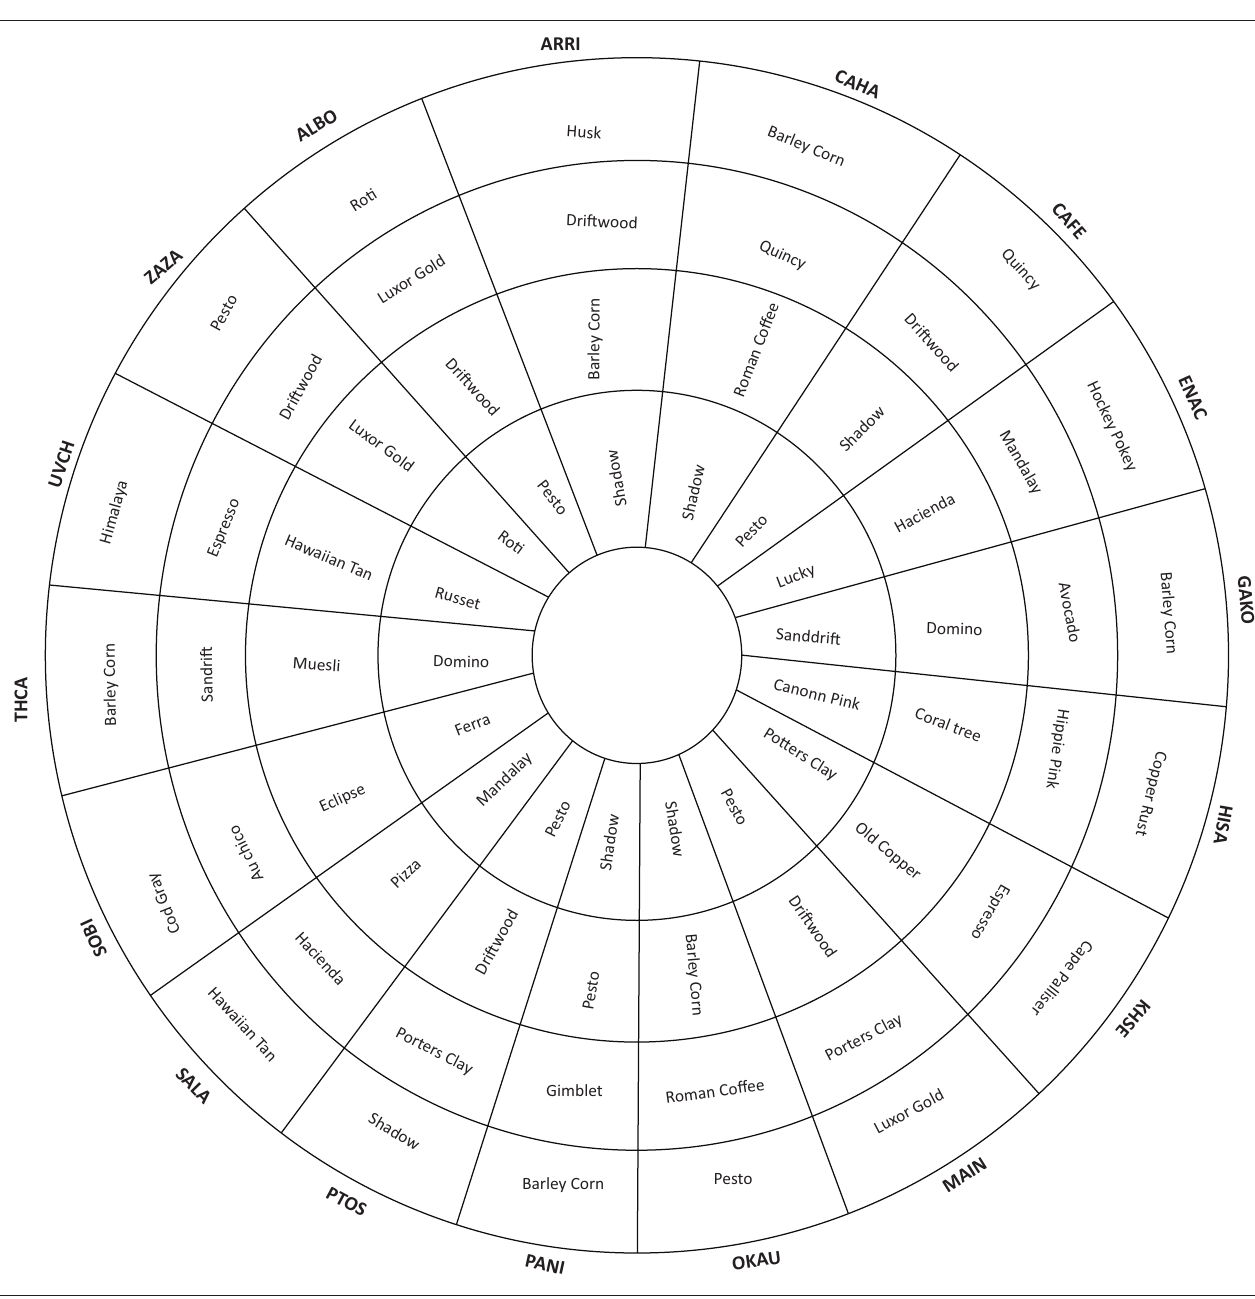
http://www.jomped.co.za Open Access